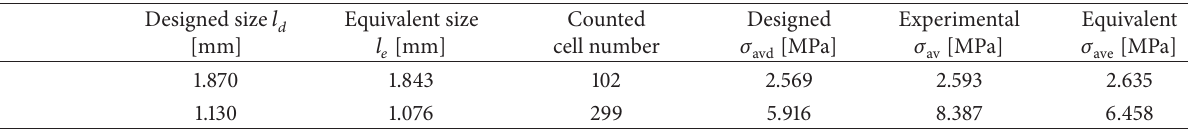
Table 3: Parameters of H1 and H2 about the equivalent method.